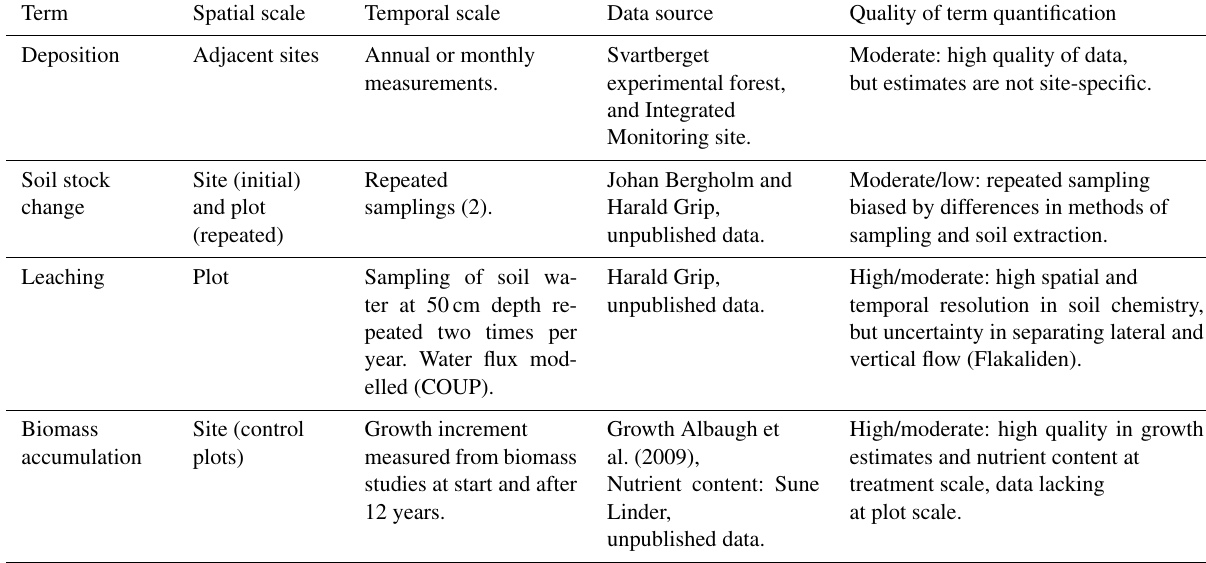
Table 5. Judgement of data quality for terms included in the base cation budget estimate of weathering. Term Spatial scale Temporal scale Data source Quality of term quantification Deposition Adjacent sites Annual or monthly